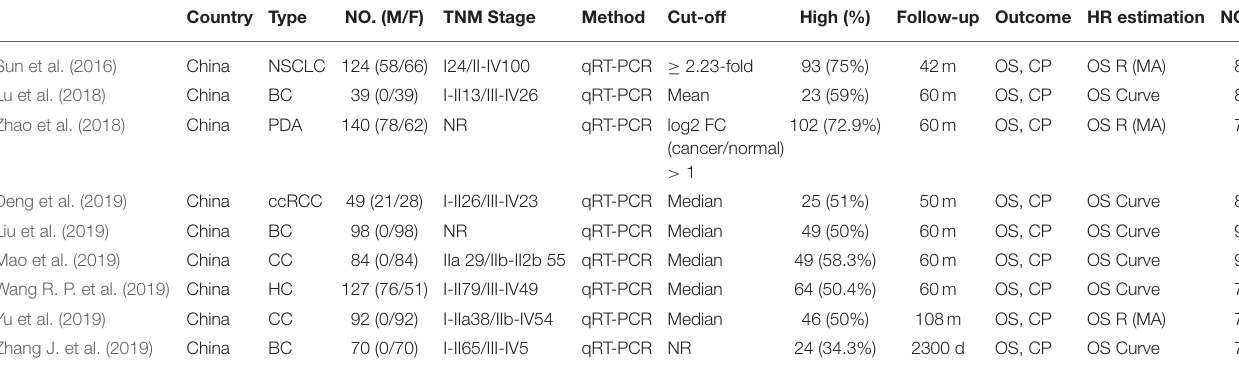
TABLE 1 | The main characteristics of the included studies in this